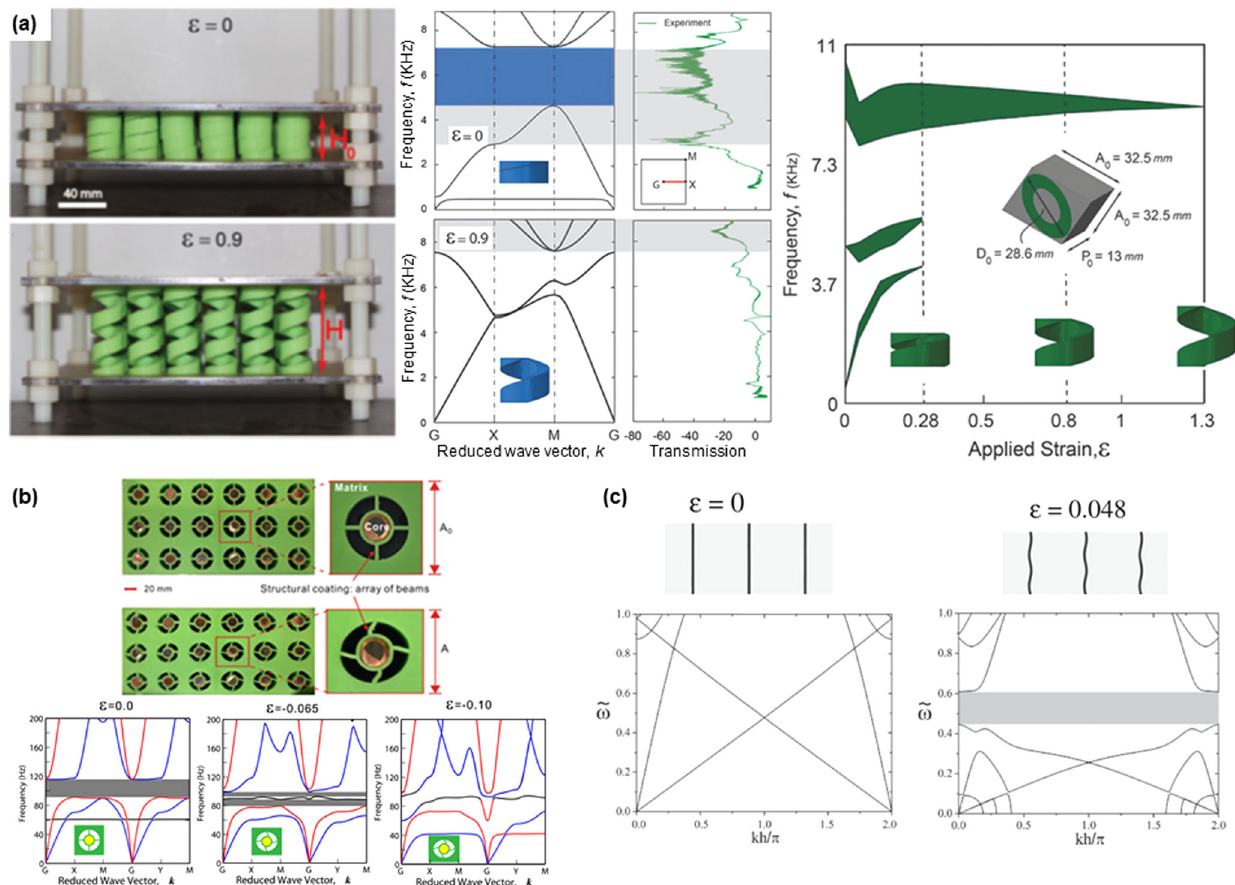
Fig. 4 Acoustic metamaterials. a Optical images of the initial and deformed acoustic metamatrials composed of an array of 6 by 6 stretchable helices (upper left). When the array is arranged in a square lattice, calculated band structures of the initial and deformed metamatrials show a stretching of 0.9 leads to the switch-off of the band gap (marked by the blue region) (left). The right shows the evolution of the band gap for a triangular array (a stretching of 1.3 for close-up of the band gap). Adapted with permission from ref. 57. b Each resonator consists of a metallic mass core connected to the matrix through four elastic beams, where black regions indicate voids in the structure (top). When a compressive strain of 0.10 is applied in the vertical direction, buckling of the vertical beams alters the effective stiffness of the structure. The band structure is split and eventually turned off for an increasing compression. Reprinted with permission from ref. 58. c Due to a mechanical mismatch between adjacent layers, interfacial buckling in a periodic multilayered structure opens up a band gap. Reprinted with permission from ref.